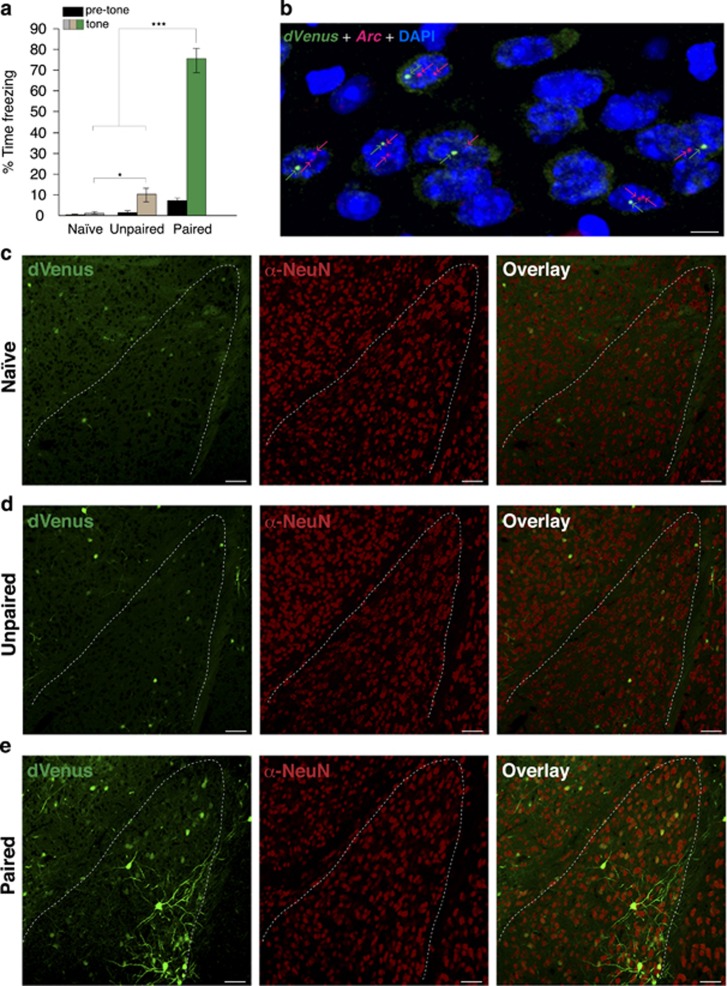
Fear conditioning induces learning-specific activation of Arc-dVenus in the lateral amygdala (LA). (a) Tone-induced freezing in naïve mice, and those receiving either paired or unpaired presentations of tone and shock (n=8 mice/group). One-way analysis of variance, F=107.07, P<0.001. *P<0.05, ***P<0.001. (b) Arc-dVenus reporter and endogenous Arc RNA intra-nuclear foci (indicated by arrows) are highly co-localized. Scale bar, 5 μm. (c–e) Arc-dVenus+ expression in the LA of mice from naïve (c), unpaired (d) and paired (e) conditions killed 5 h post training. Dotted lines indicate LA boundaries. Scale bar, 50 μm. (f and g) Matching the cell-type specificity of endogenous Arc expression, Arc-dVenus+ neurons in the LA uniformly express the glutamatergic marker Tbr1 (n=1900 cells; F), but not the GABAergic marker GAD67 (n=1140 cells; G). Scale bar, 10 μm.